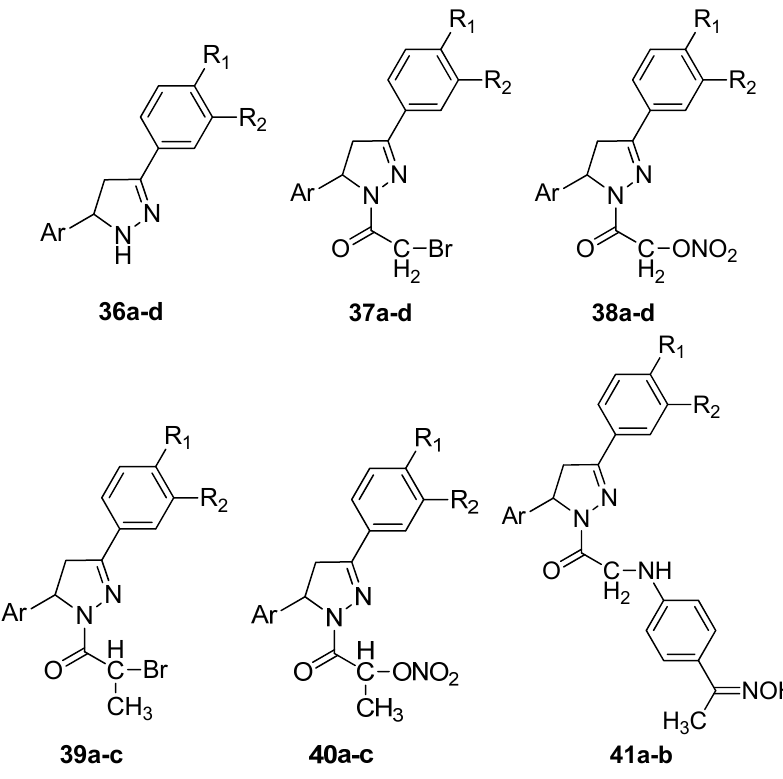
Figure 25. Diaryl pyrazoline hybrid derivatives ( a R b = R = R = OCH , Ar = 2,4-Di-OCH 1 2 3